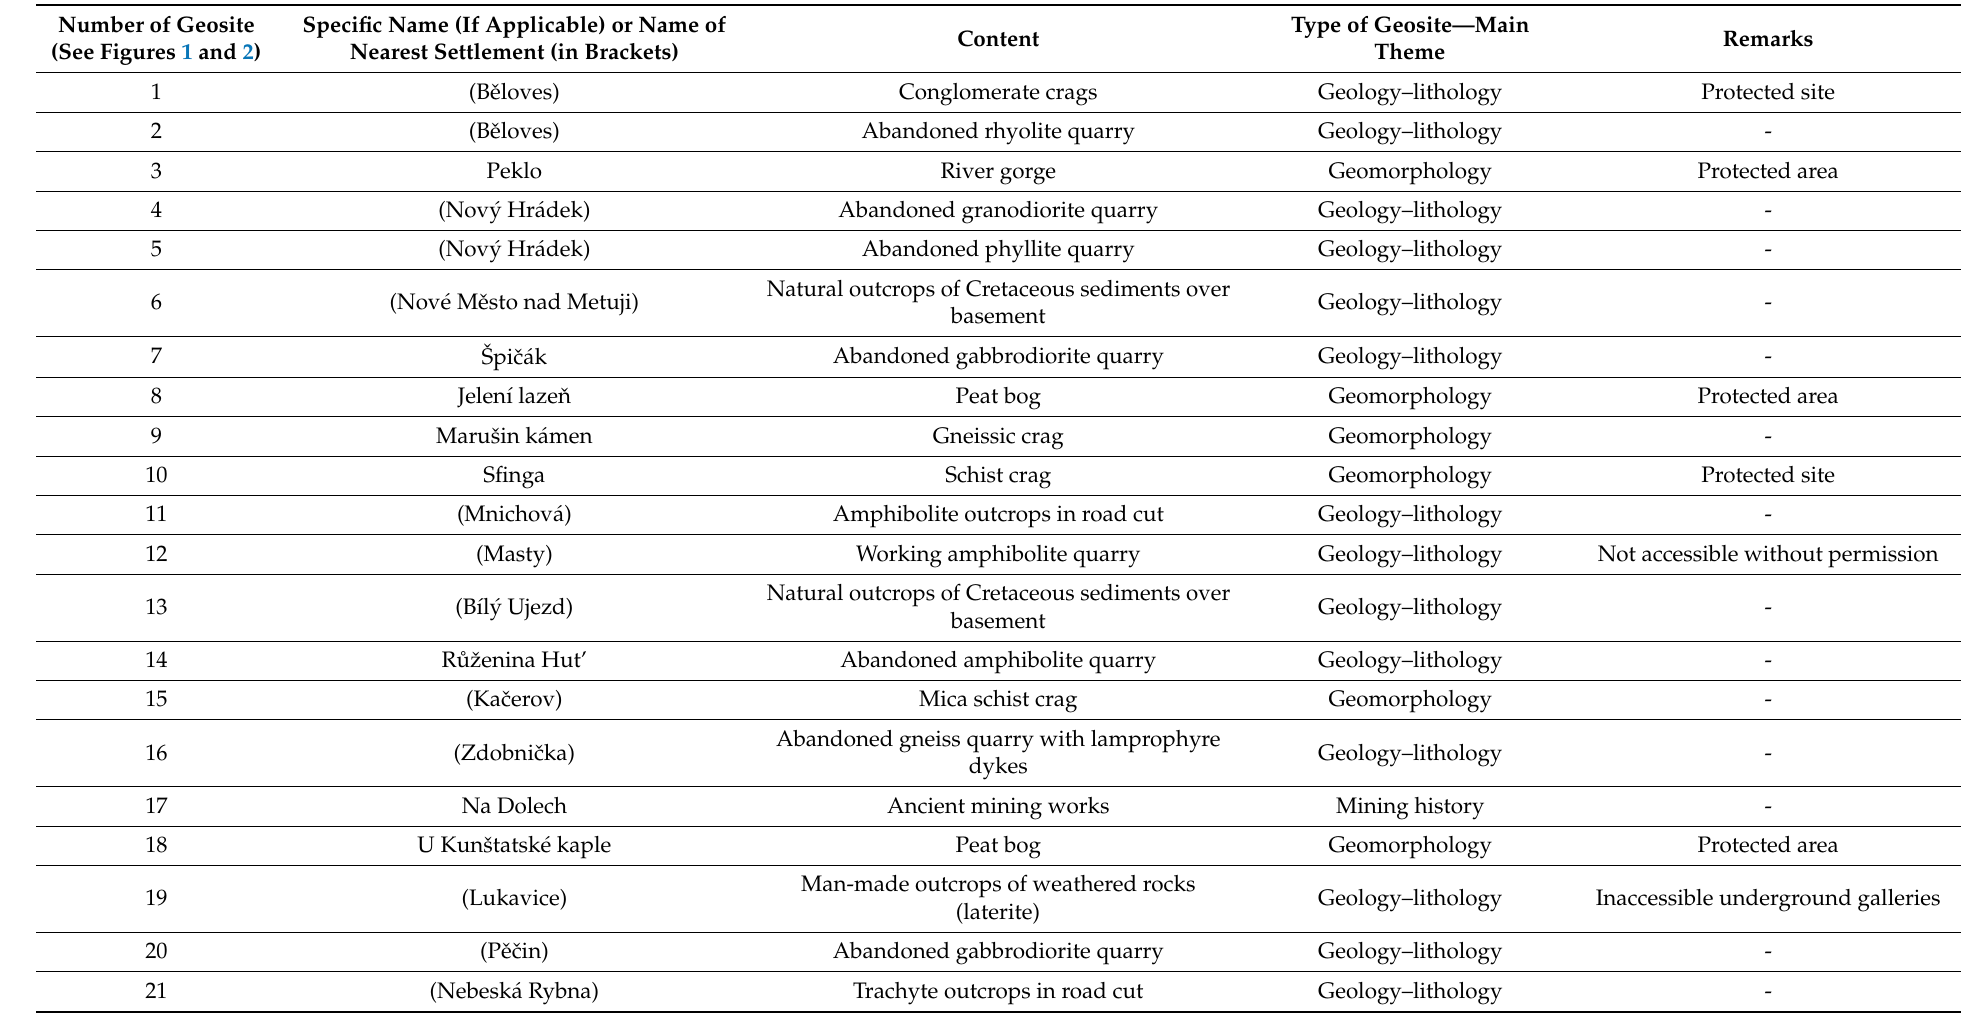
Table 1. List of geosites in the Czech part of the Orlick é –Bystrzyckie Mountains Block, included into the database of the Czech Geological Survey